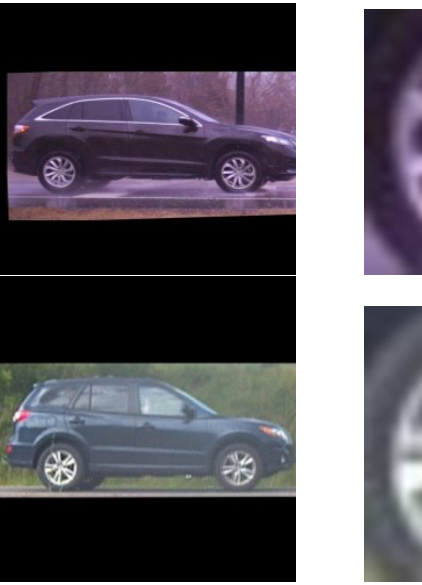
Figure 3. Two vehicle images and their detected